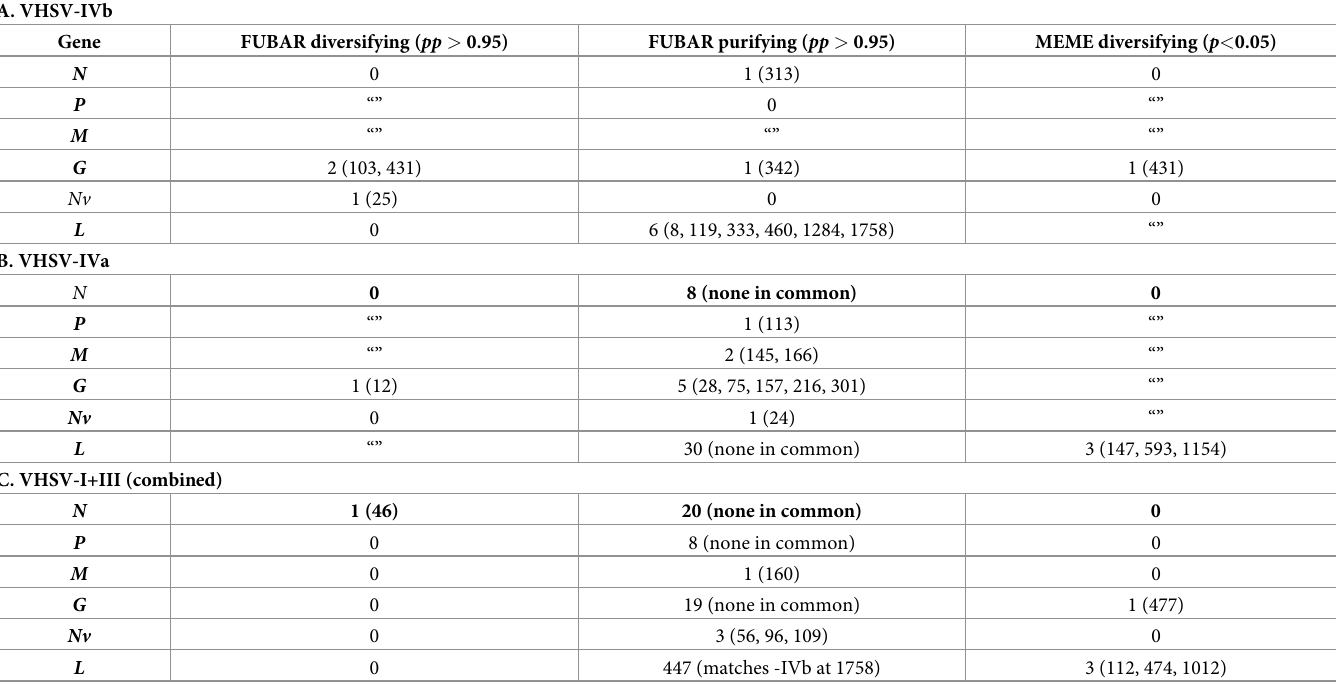
Table 2. Positive (diversifying) or negative (purifying) selection pressures on individual codons for genes from whole genome sequences, determined by FUBAR (fast, unconstrained Bayesian approximation) and MEME (mixed effects model of evolution) analyses [70, 71] for (A) VHSV-IVb, (B) VHSV-IVa, and (C) VHSV-I +III (combined).